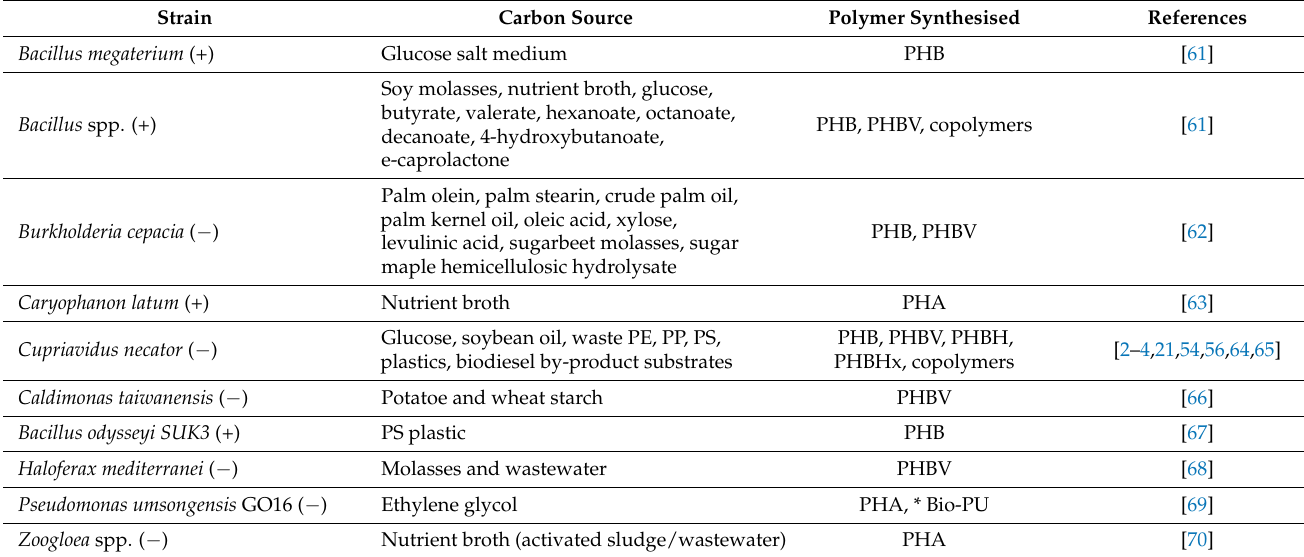
Table 2. Notable research of bioplastic production from the last 15 years on Gram-positive (+) and Gram-negative ( − ) bacterial strains, with their respective carbon sources and biopolymers produced. * Bio-PU a novel bio-based poly (amide